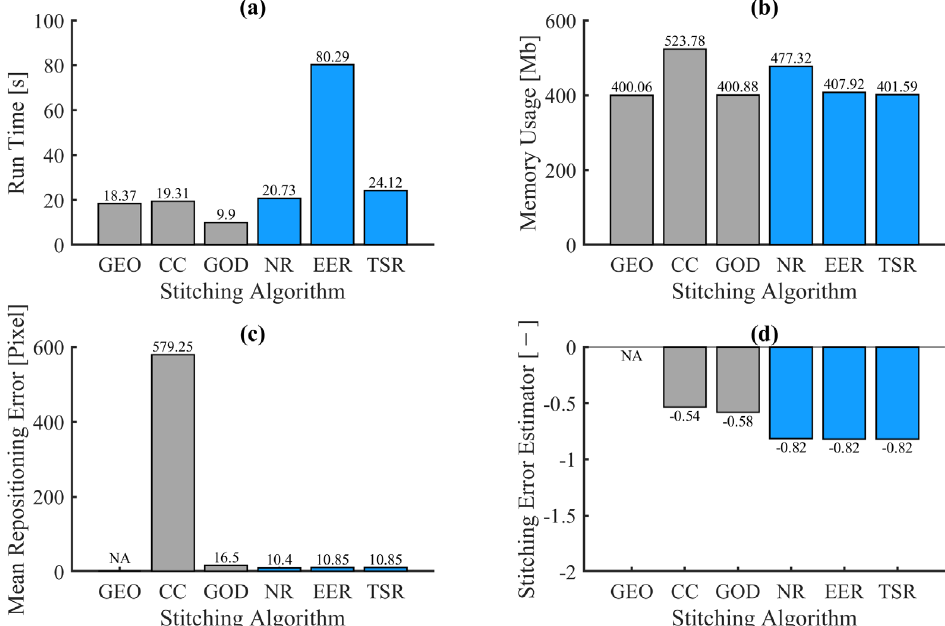
Figure 11. Bar charts of the quantitative criteria for test case B: run time ( a ), memory usage ( b ), mean repositioning error ( c ) and stitching error estimator ( d ). NA = Not applicable.